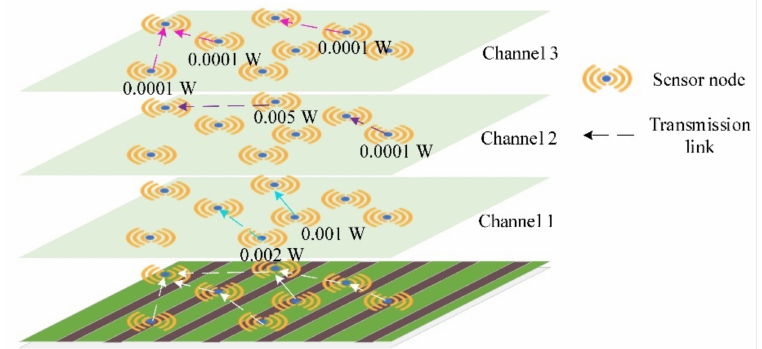
Figure 1. Schematic diagram of power control and channel allocation in an agricultural